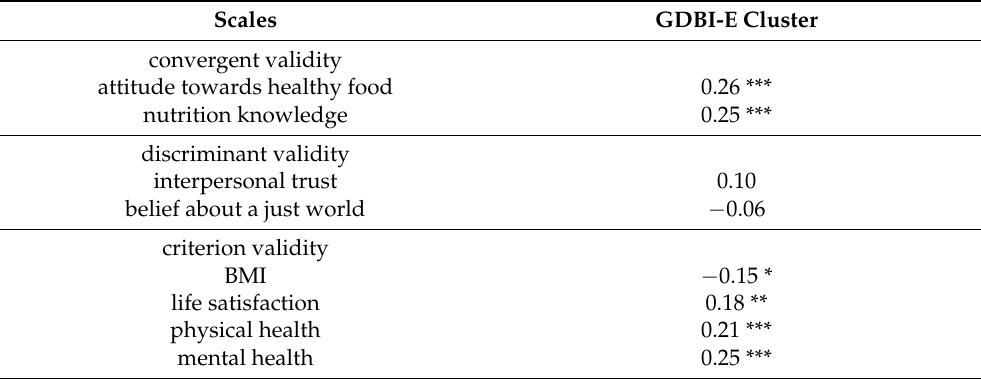
Table 4. Pearson correlation coefficients for construct and criterion validity of the GDBI-E cluster assignment.